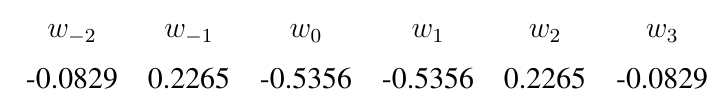
Table 2. Precomputed weights in circular